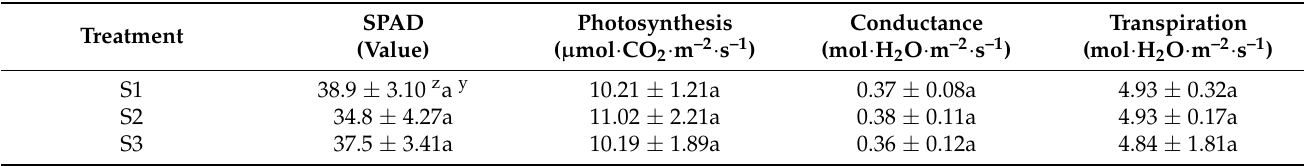
Table 2. Effect of substrate composition on SPAD, photosynthesis rate, stomatal conductance, and transpiration rate of M-9 apple rootstock plant at 11 weeks after treatment. S1, S2 and S3 indicate 1:1:1, 1:2:3, and 3:1:2 ratio of peat moss: vermiculite: perlite